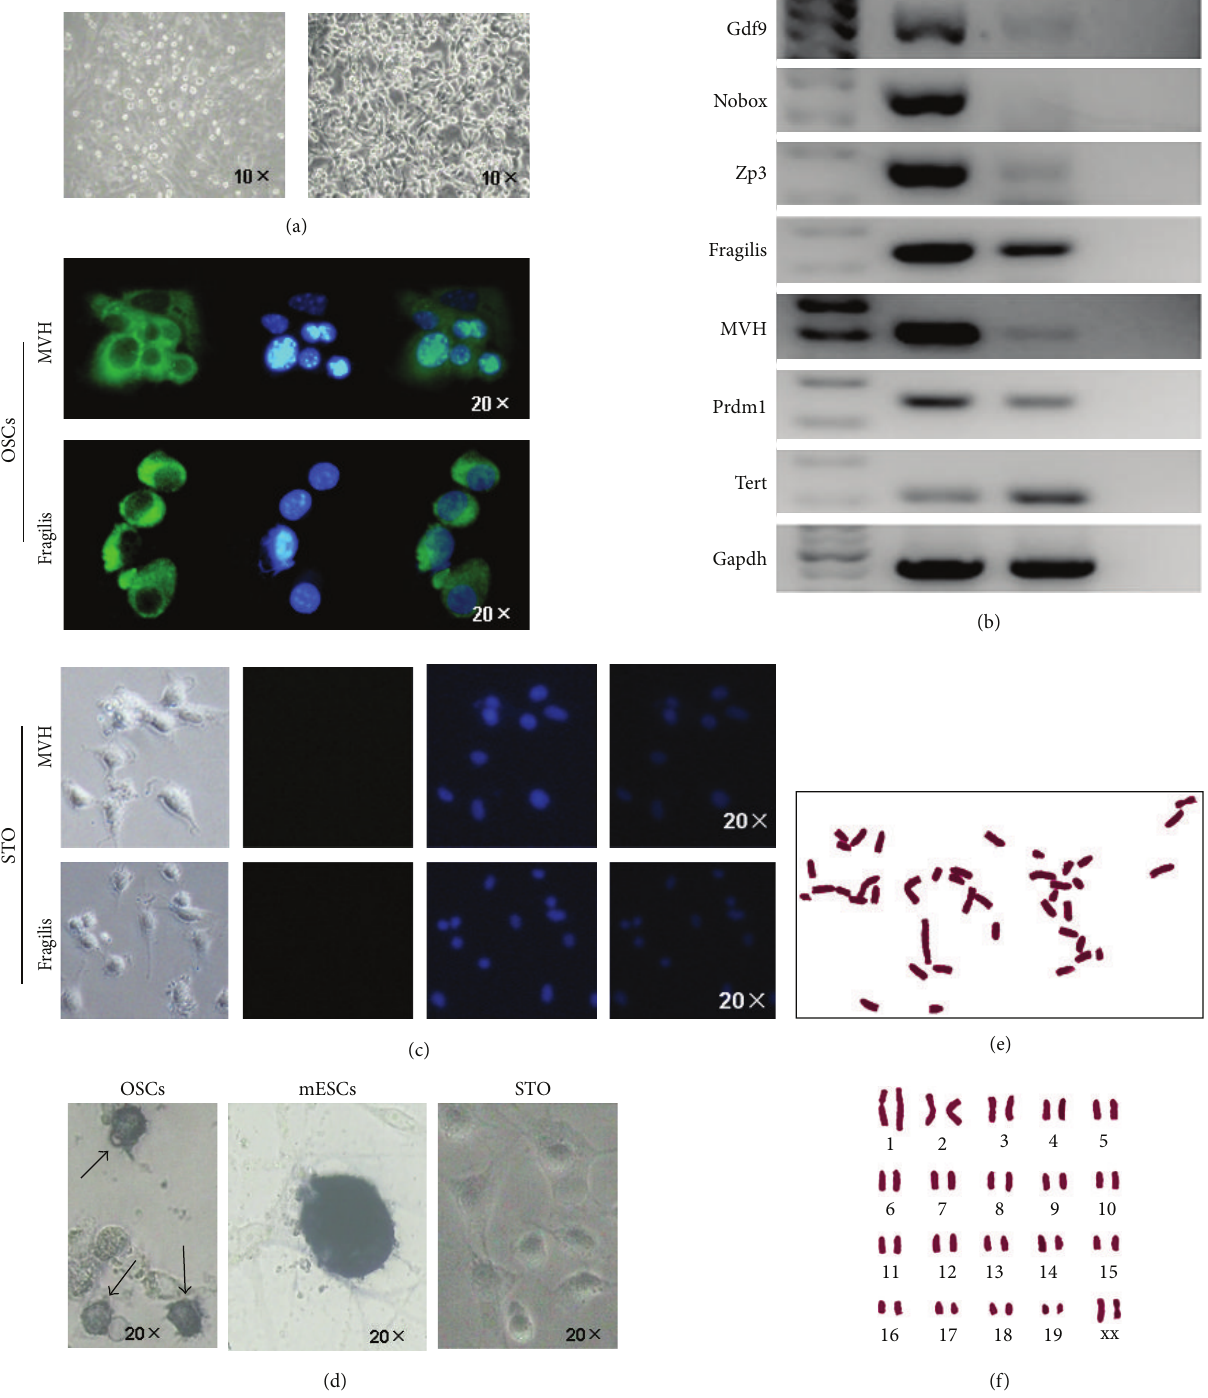
Figure 1: Morphology and characteristics of the established OSCs. (a) Overview of the OSCs immediately after MACS (left) and the established OSCs (right) which formed the typical structure of cell clusters. (b) Reverse transcriptional PCR analysis for expression profile of OSCs and ovarian tissues as the positive control. There were two set of genes: one for oocytes including Gdf9, Nobox, and Zp3 and another one for germ cells including Fragilis, MVH, Prdm1, and Tert, displaying that OSCs are characteristic of germ cells. No RT, PCR of RNA sample without reverse transcription. (c) Immunofluorescence for MVH and Fragilis in established OSCs and STO as negative control. Green, MVH, and Fragilis immunofluorescence; Blue, DAPI. At the bottom are the images (bright field, Green, DAPI, and merge) of STO from left to right. (d) Alkaline phosphatase staining for established OSCs, mESCs, and STO showed that OSCs (arrows) were positive, whereas mESCs were strongly positive. mESCs, mouse embryonic stem cells. (e-f) Cytogenetic analysis for established OSCs showed normal